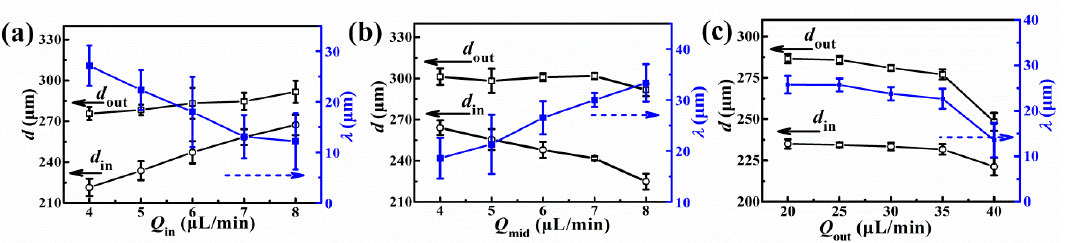
Figure 3. Droplet diameter ( d in and d out ) and λ varying with ( a ) Q in , at Q mid = 5 μ L/min and Q out = 30 μ L/min, ( b ) Q mid , at Q in = 5 μ L/min and Q out = 30 μ L/min, and ( c ) Q out , at Q in = 5 μ L/min and Q mid = 6 μ L/min.